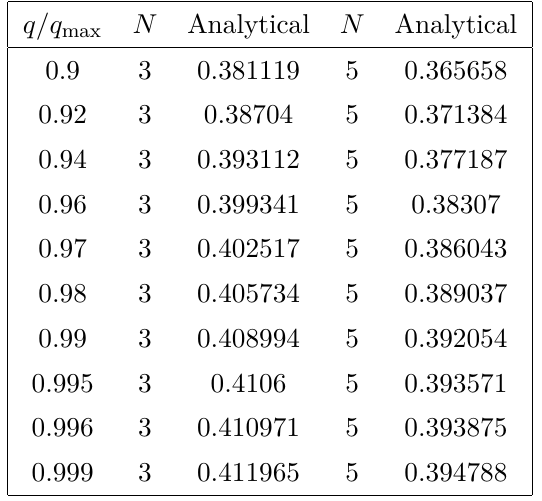
Figure 3 . We have plotted the analytical estimation of the ratio − ( Im ω/κ − ) against the ratio ( q/q max ) , where we have taken the value of the cosmological constant to be Λ = − 0 . 1 and the mass to be M = 1 , for two different choices of the Lovelock order N .